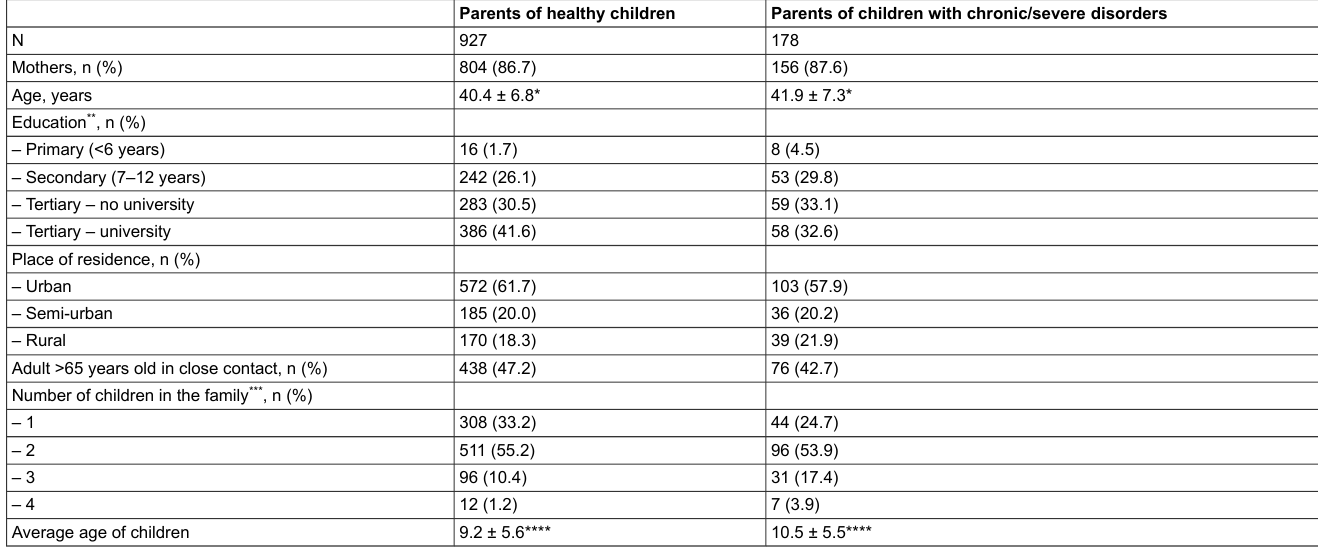
Table 1: Characteristics of study participants.